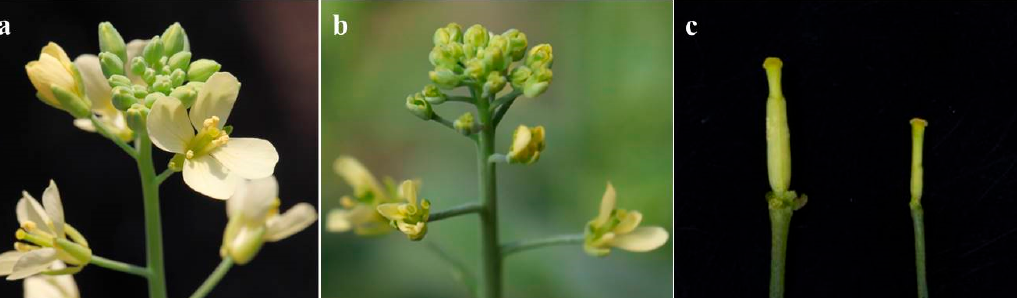
Figure 11. Two female-sterile mutants. ( a ) wild-type ‘FT’ plants; ( b ) female-sterile mutants; ( c ) pistils of wild-type ‘FT’ (left) and female-sterile mutants (right).